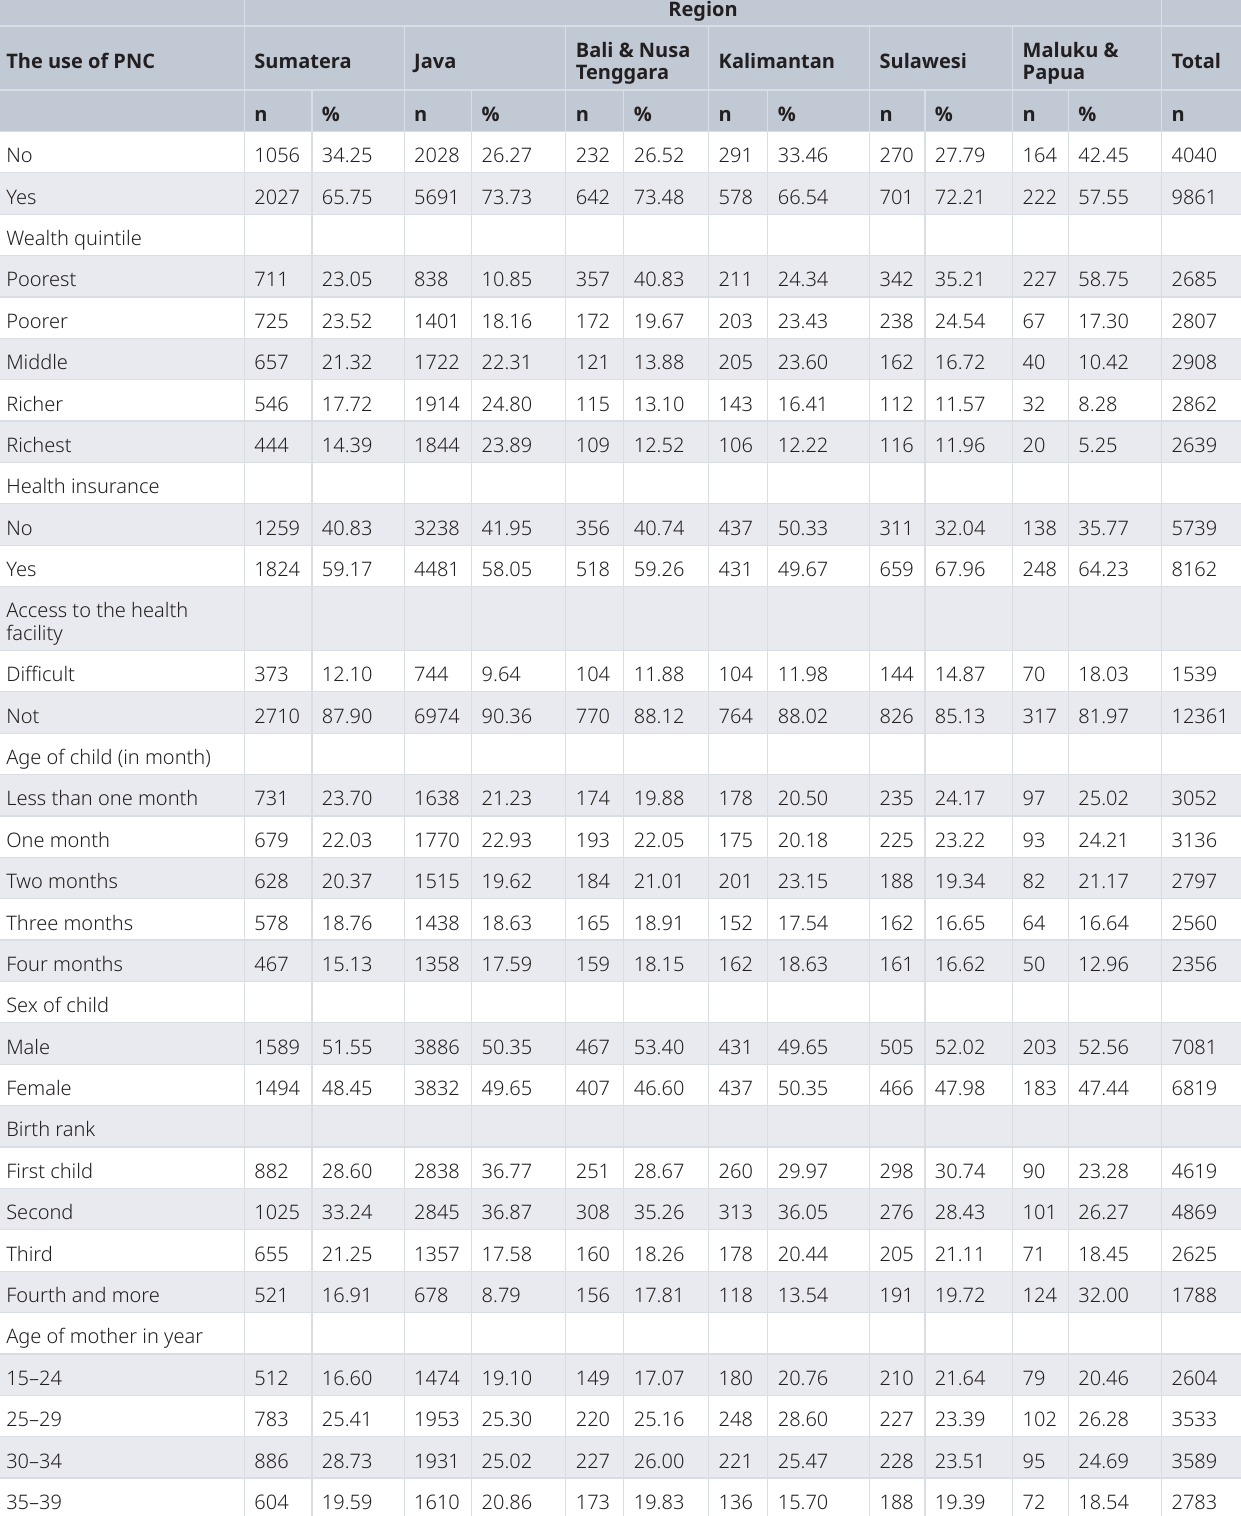
Table 3. Sociodemographic characteristic of participants PNC in Indonesia based on region (n=13,901).